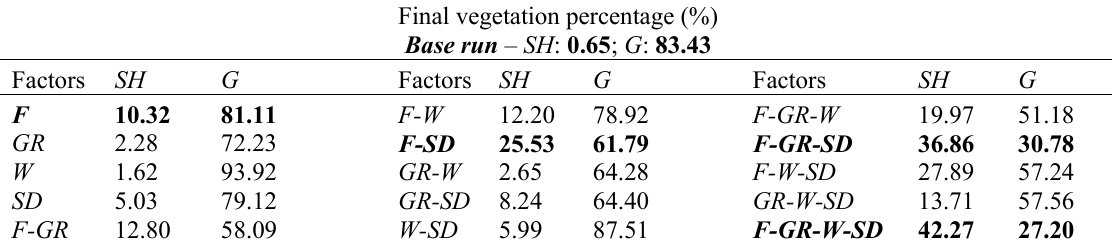
Final vegetation percentage